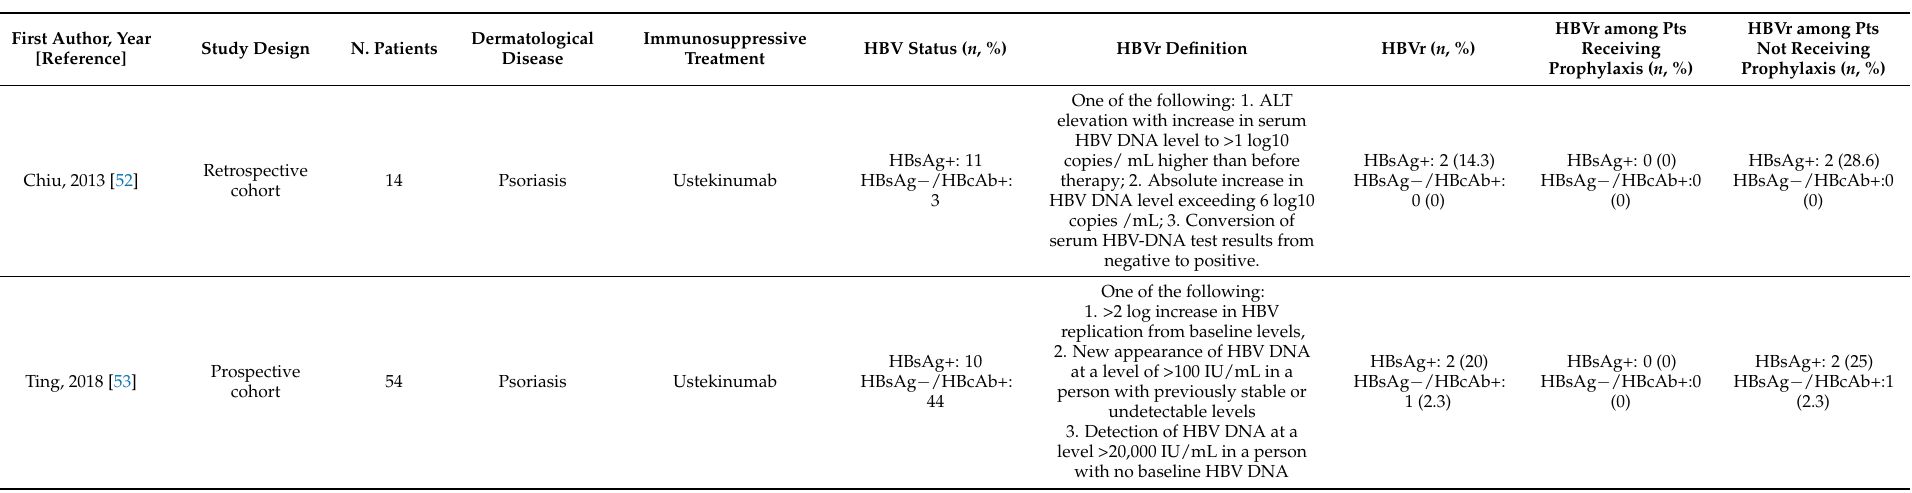
Table 2. Studies on HBV reactivation in patients with dermatological